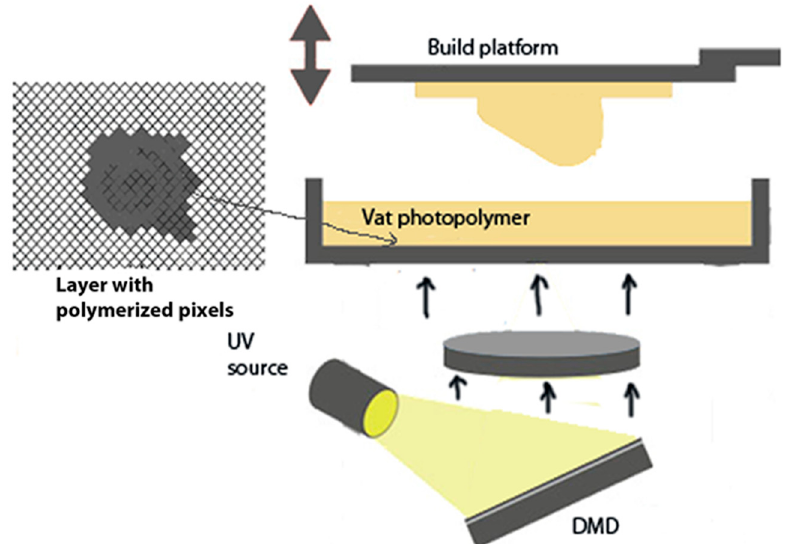
Figure 1. Outline of digital light processing (DLP).